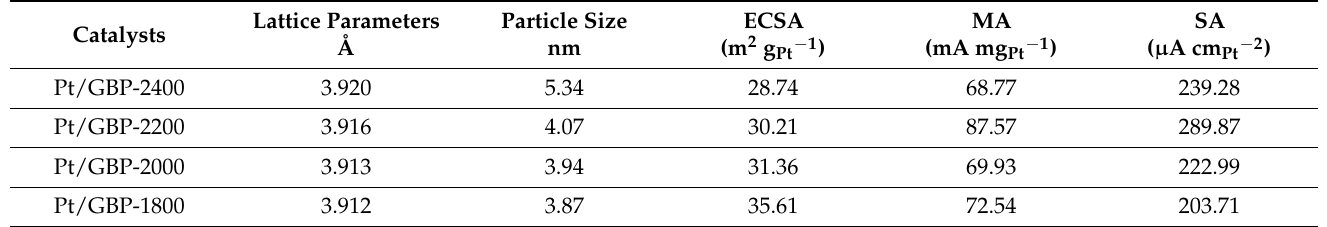
Figure 2. ( a ) CV curves, and ( b ) LSV curves of catalyst prepared by support at different heat treatment temperatures. Table 3. The characteristics and electrochemical performance comparison of as-prepared Pt/GBP at different temperatures.